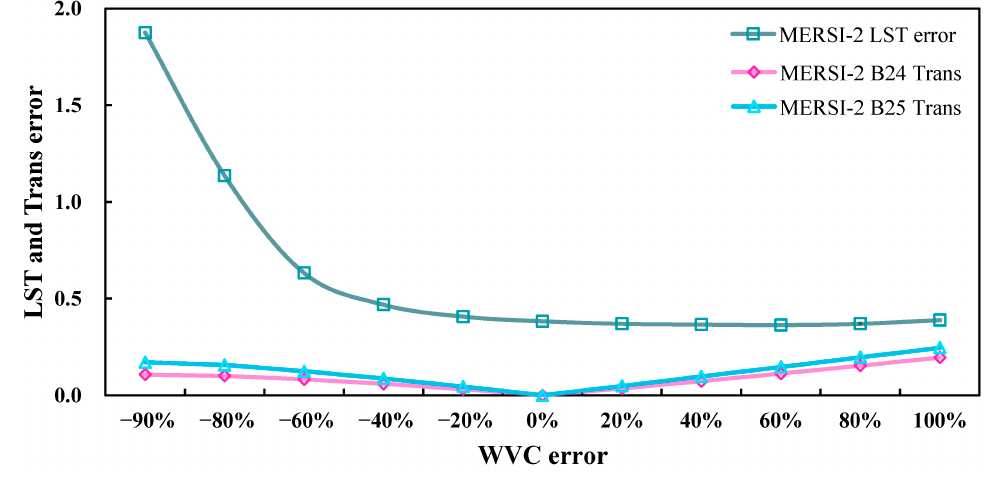
Figure 16. Variations in LST and transmittance errors caused by variations in WVC